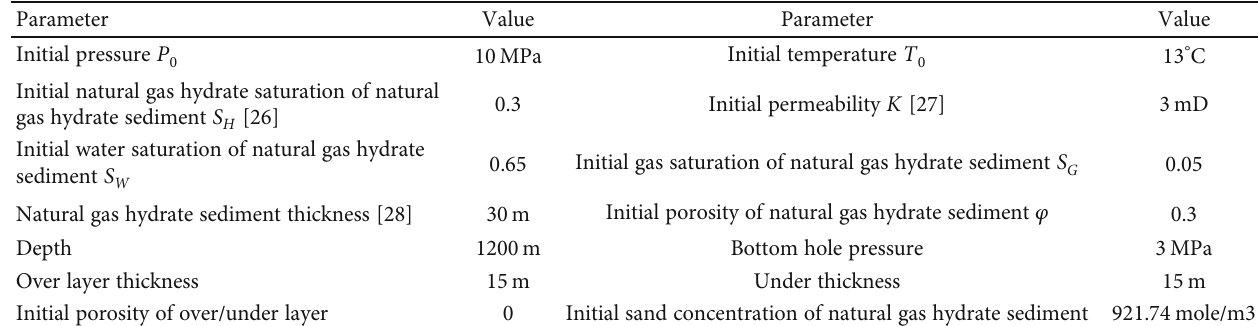
Table 1: Important model parameter.